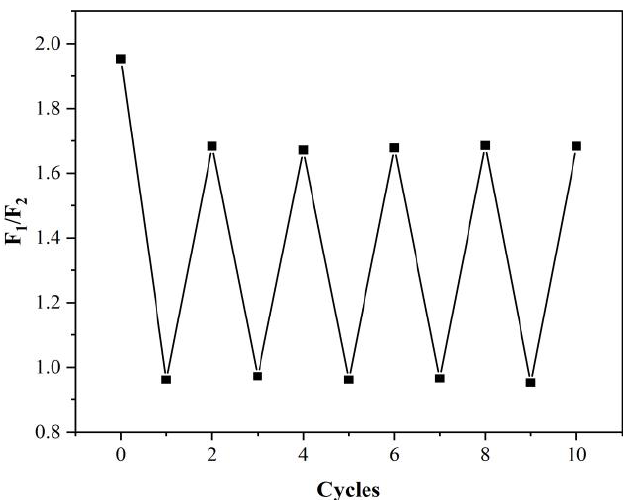
Figure 16. ( a ) Illustration of the fluorescent logic gates based on the N-CD/calcein sensor; ( b ) the histogram of logic gates with various inputs.